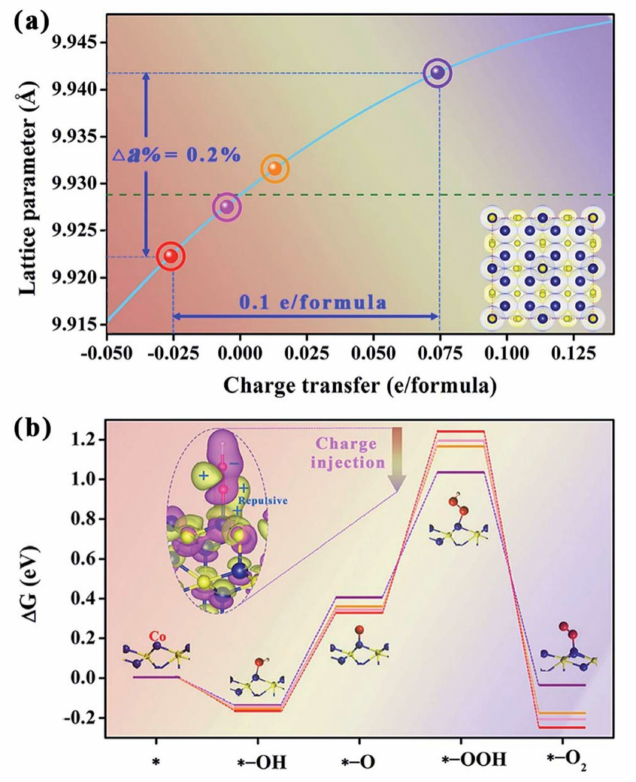
Figure 11. ( a ) DFT analysis of the dependence of lattice parameter of Co 9 S 8 on the variation of injected charge transfer; ( b ) DFT calculated free energy landscape for the OER at 1.23 V vs. RHE (the standard potential for OER) on the Co 9 S 8 (100) surface at different charging states. Inset in ( a ): structural model of the Co 9 S 8 crystal; ( b ): absorption structure and charge density redistribution at different charging states (atoms with blue, yellow, red, and white colours represent Co, S, O and H atoms, respectively). Reproduced from Ref. [179] with permission from the Royal Society of